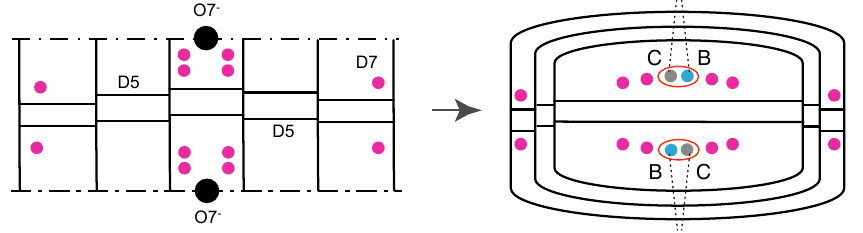
Figure 49 . T-dual version of 6d brane con(cid:12)guration for the [8]